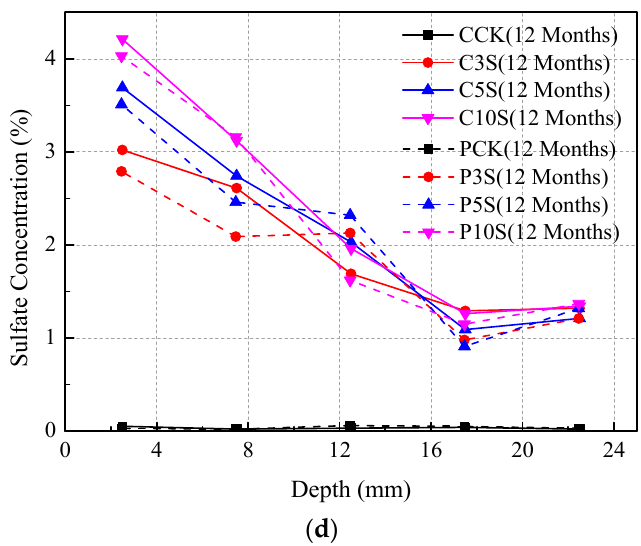
Figure 3. Sulfate concentration of concrete with different water/cement ratios: ( a ) 0.55, in 10% sulfate solution, ( b ) 0.40, in different solutions, ( c ) 0.48, in different solutions, and ( d ) 0.55, in different solutions.